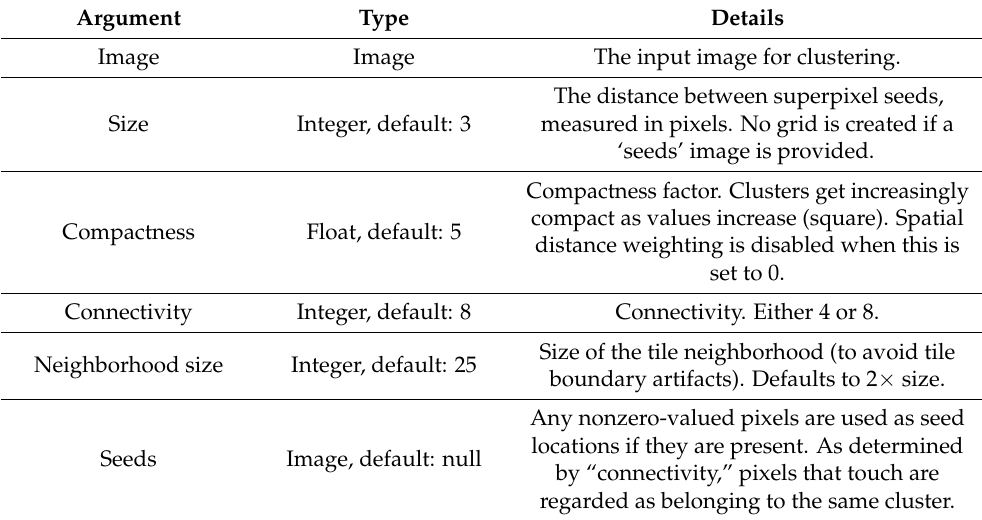
Table 7. Determination of optimum segmentation parameter values for study